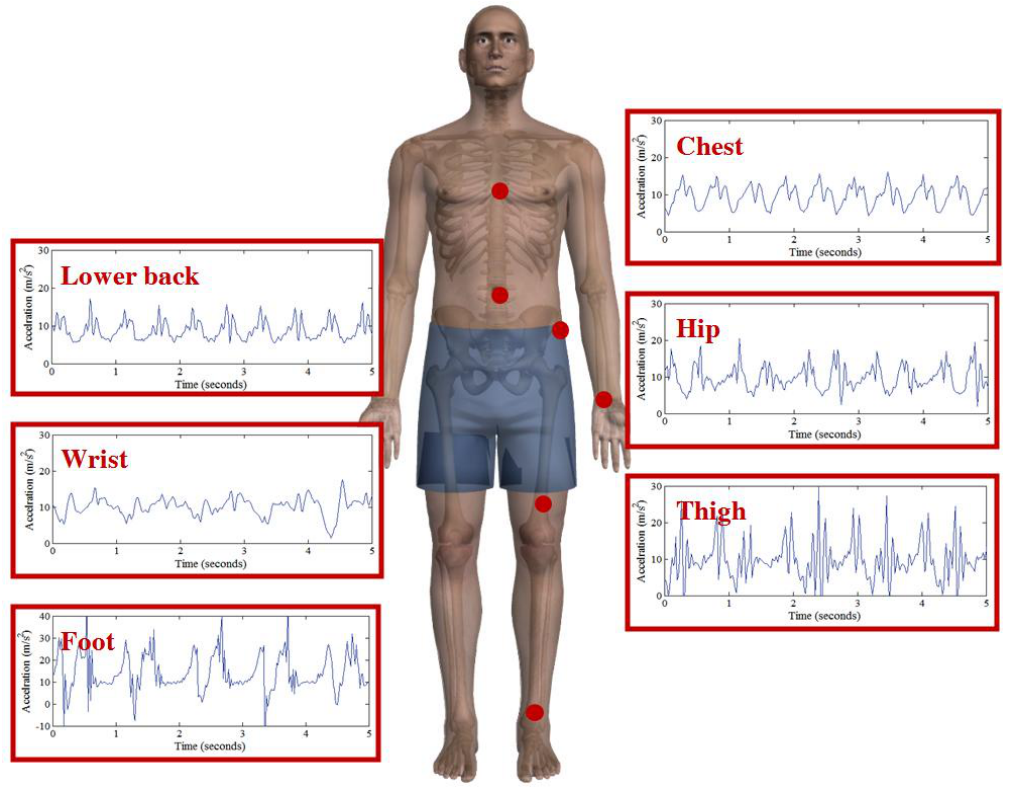
Figure 1. Five second recording of simultaneous vertical acceleration obtained from accelerometers placed on the chest, lower back, wrist, hip, thigh and foot. Acceleration data was sampled at 50 Hz using an accelerometer with a range of ±6